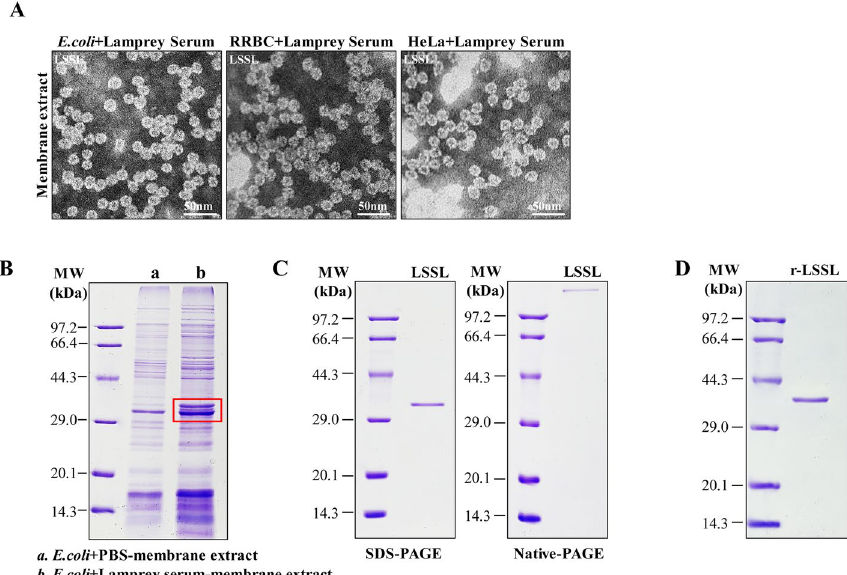
Fig. 1 Identification of LSSL in lamprey serum. A Transmission electron microscopy (TEM) of membrane proteins from Escherichia coli , rabbit red blood cells (RRBCs), and HeLa cells treated with lamprey serum. Scale bar, 50 nm. B SDS–PAGE of membrane proteins extracted from E. coli treated with lamprey serum. The membrane proteins extracted from PBS-treated E. coli were used as the control. Protein bands (red box) were identified using mass spectrometry. C Detection of native LSSL protein purified from lamprey serum using SDS–PAGE and Native–PAGE. The molecular weight of the LSSL monomer is about 35 kDa. D SDS–PAGE of recombinant LSSL protein, the molecular weight of which is approximately 38